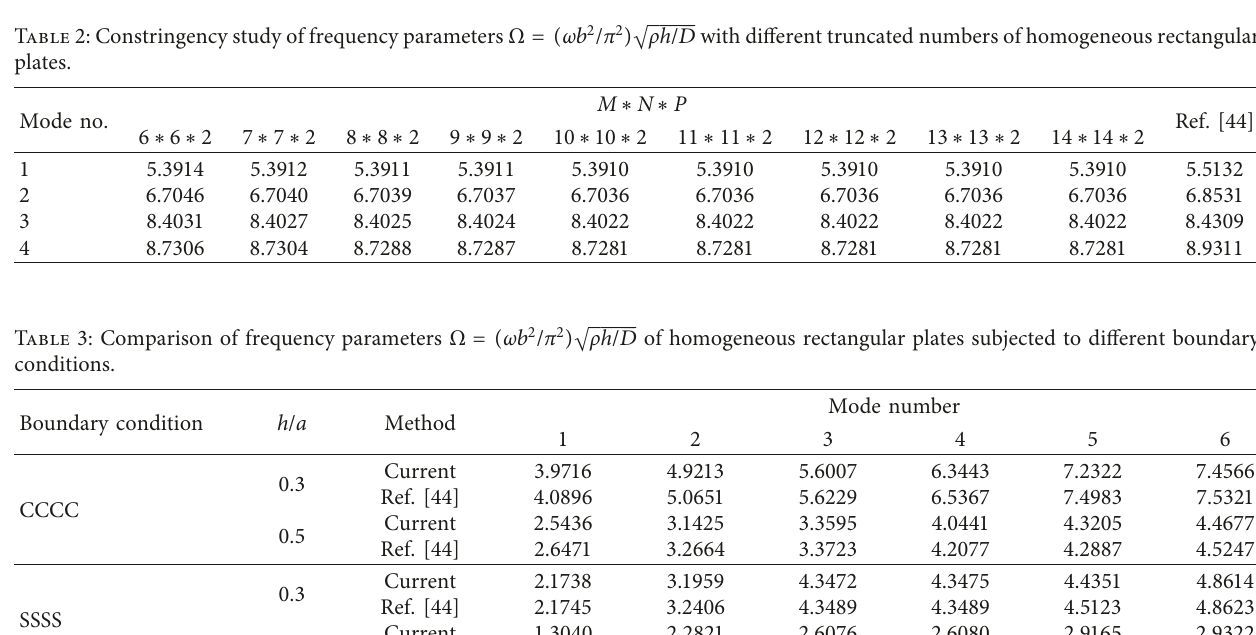
����� 􏽰 ρ h / D with different truncated numbers of homogeneous rectangular